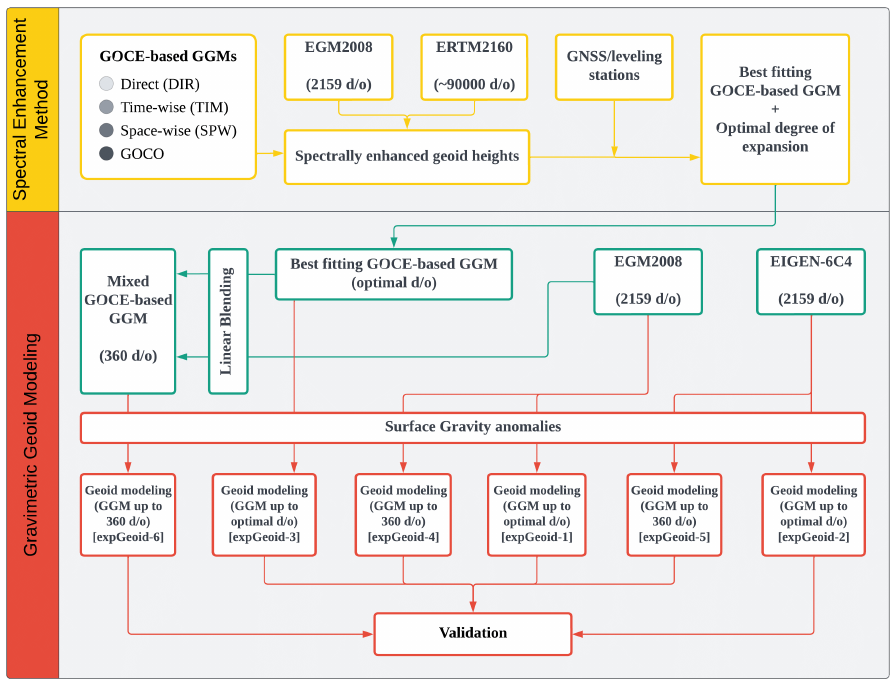
Figure 4. The flowchart of the study. Yellow: spectral enhancement method, green: combining the GGMs, red: gravimetric geoid